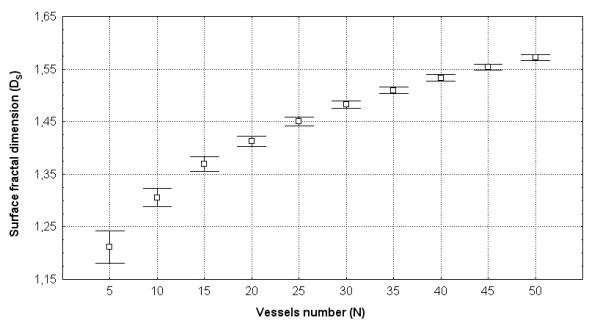
The behavior of Ds during a simulated increase in vessel density. The graph shows that different Dsvalues can be obtained for images with the same vessel density. As the only variable in these images is their distribution pattern, Ds depends on the irregular arrangement of the vessels in the surrounding environment (note the standard deviation of each cell density group). Ds also increases significantly when a higher vessel density is introduced into the system because of the greater space filled by the vascular component. The increase in vessel density reduces the variability of their space-filling properties, thus reducing the standard deviation.